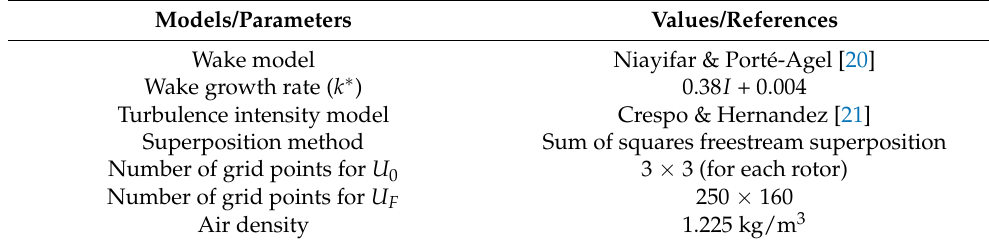
Table 2. Summary of FLORIS